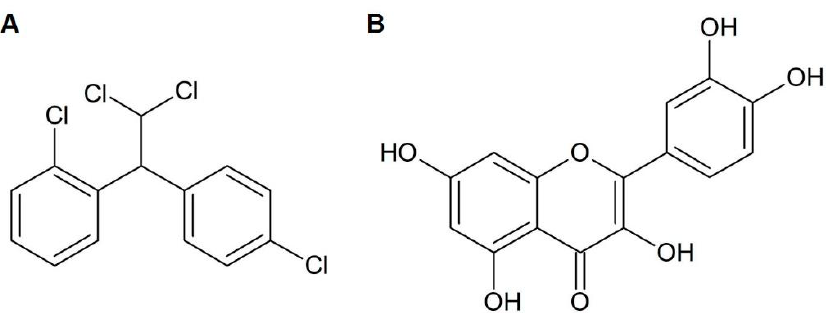
Figure 1. ( A ) Structure of mitotane; ( B ) structure of quercetin.